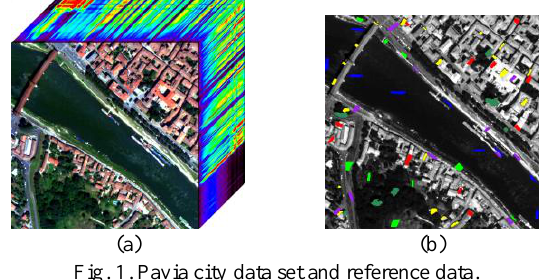
Fig. 1. Pavia city data set and reference data.